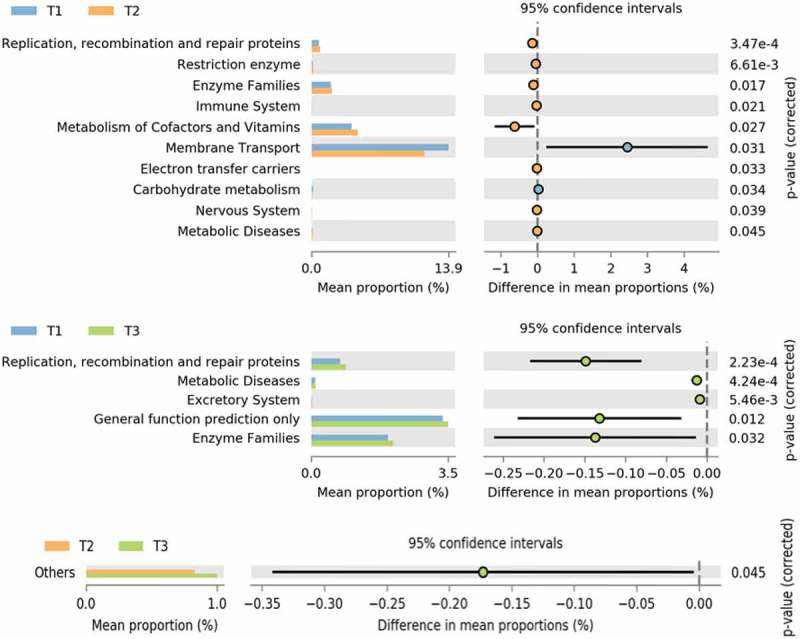
Metagenomic functional predictions pair-wise comparison between the time points (T1 – T2), (T1 – T3) and (T2 – T3) for mean relative gene pathway abundance of significantly differentially abundant modules (ANOVA; p < 0.01).